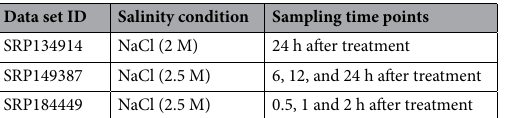
Table 1. Details of datasets and treatment conditions with hypersalinity which were used in this